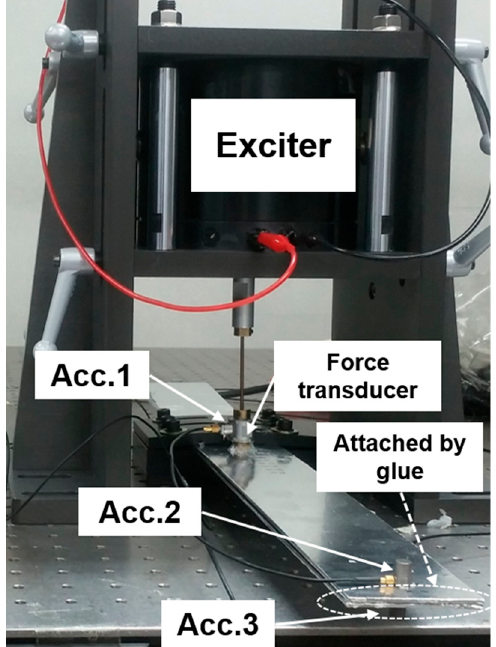
Figure 6. Experimental configuration.